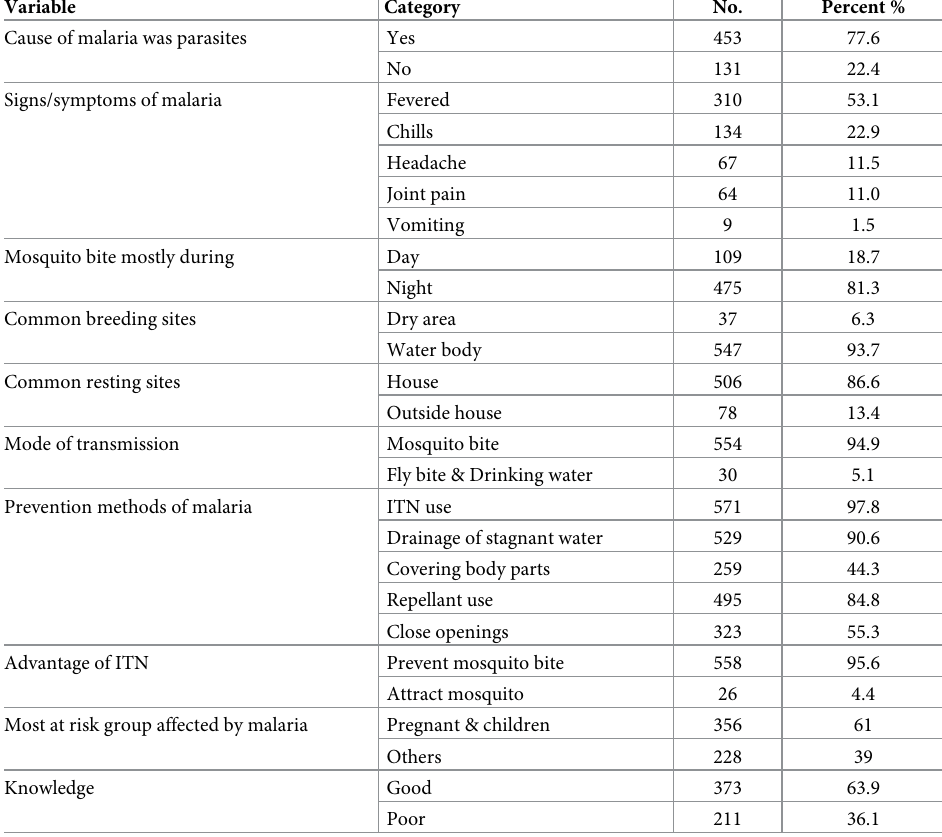
Table 2. Knowledge about malaria prevention and control among households in Hawassa City, South Ethiopia, 2020 (n = 584).